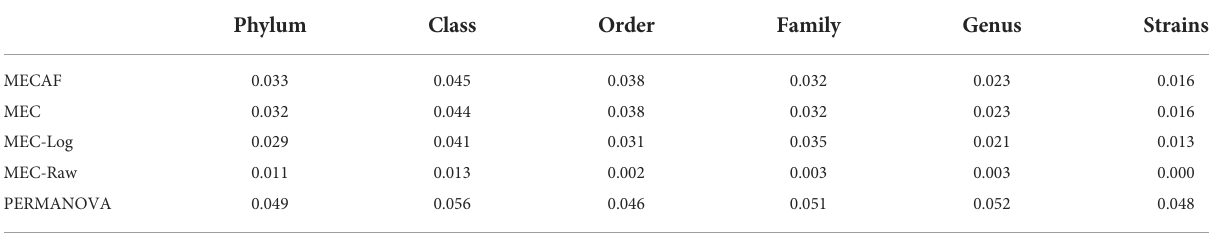
TABLE 1 Empirical type I error rate with real data from the CDI study.